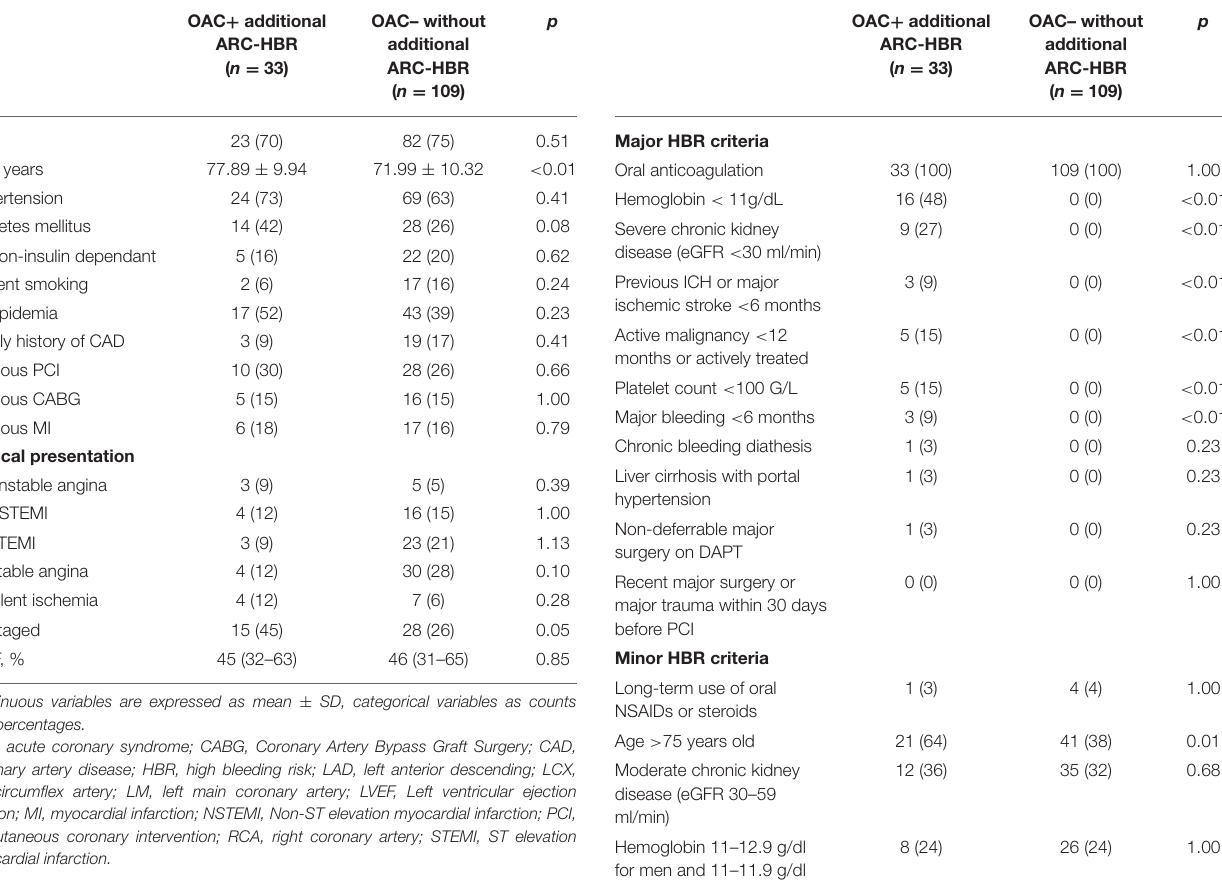
TABLE 1 | Baseline patient characteristics. TABLE 2 | Patient characteristics according to major ARC-HBR